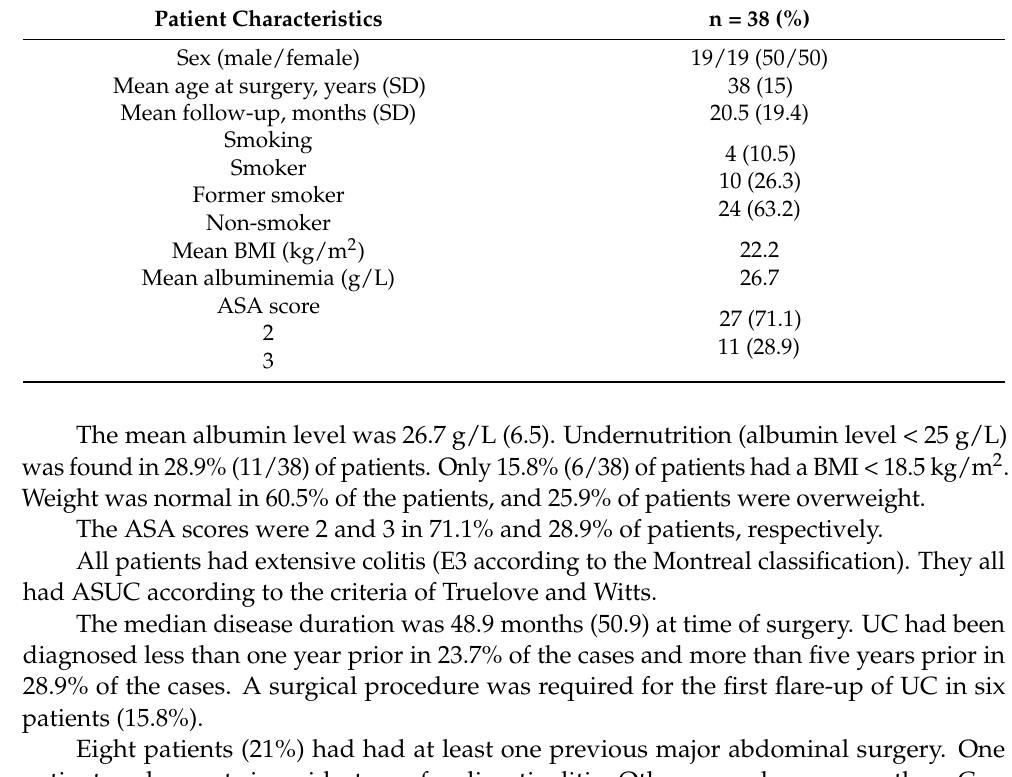
Table 1. Patient